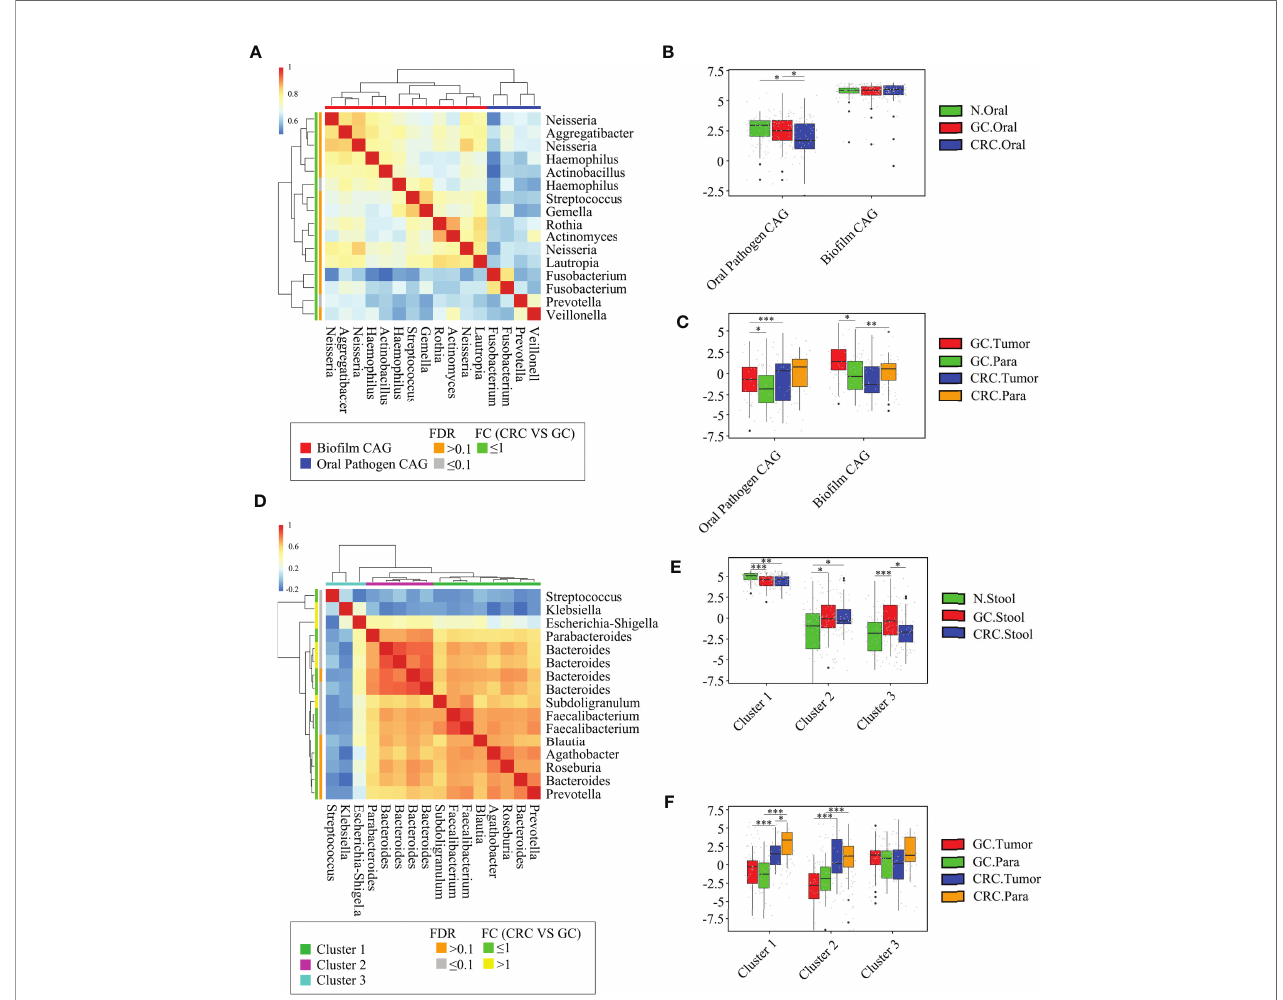
FIGURE 7 | Abundant oral and fecal microbial networks were detected in GC and CRC mucosa. Analyze the shared microbiota of the oral cavity and tissue of HC, GC, and CRC participants: (A) 16 oral microbial OTUs associated with GC and CRC tissue were aggregated into two coabundance groups (CAGs). CAGs were de fi ned in terms of clusters in a vertical or horizontal dendrogram and were named after their most prominent features. (B) Relative abundance of Oral pathogen CAG and Bio fi lm CAG in three groups of oral samples (HC = 70, GC = 70, and CRC = 42). (C) The relative abundance of Oral pathogen CAG and Bio fi lm CAG in GC and CRC tissue samples (GC.Tumor = 33, GC.Para = 36, CRC.Tumor = 24, and CRC.Para = 24). Analyze the shared microbiota of the stool and tissue of HC, GC, and CRC participants: (D) 16 fecal microbial OTUs associated with GC and CRC tissue were aggregated into three CAGs. CAGs were de fi ned in terms of clusters in a vertical or horizontal dendrogram and were named after their most prominent features. (E) The relative abundance of Cluster 1, Cluster 2, and Cluster 3 in fecal samples of the three groups (HC = 70, GC = 49, and CRC = 33). (F) The relative abundance of Cluster 1, Cluster 2, and Cluster 3 in GC and CRC tissue samples (GC.Tumor = 33, GC.Para = 36, CRC.Tumor = 24, and CRC.Para = 24). * p < 0.05, ** p < 0.01, *** p <